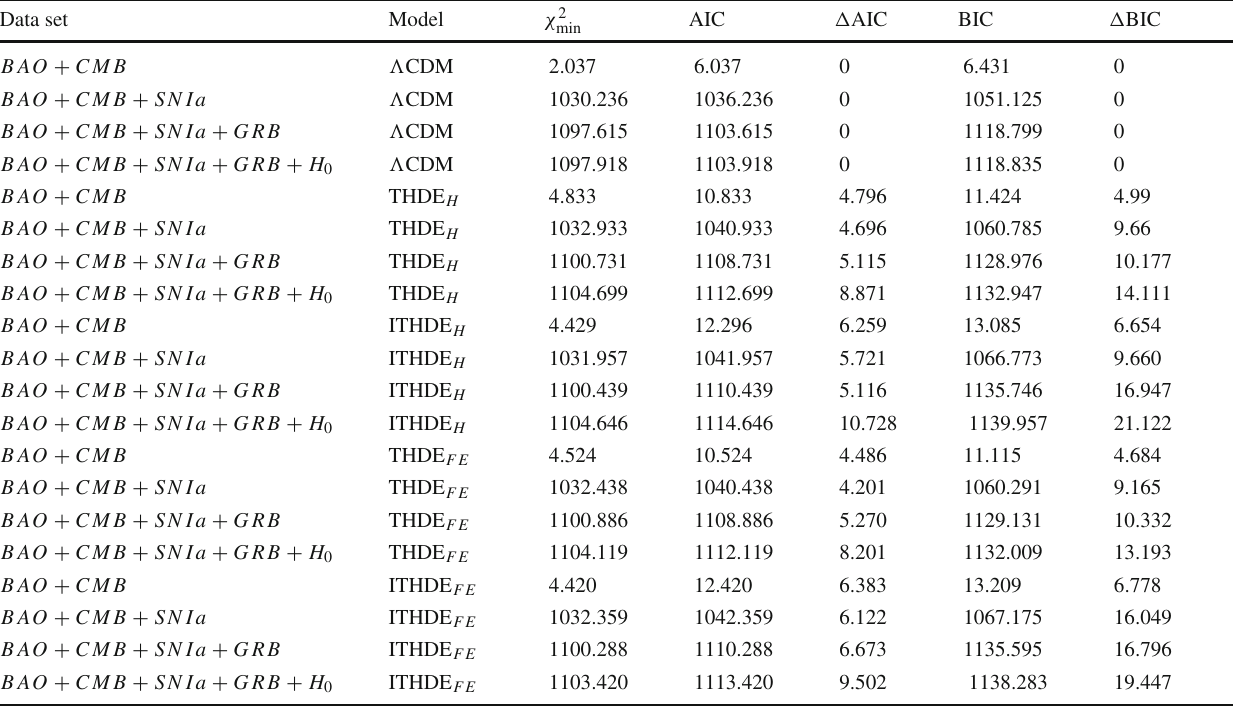
Table 4 Summary of the AIC and BIC values calculated for inter- with N = 5 interacting THDE, N = 4 for non-interacting THDE and N = 3 for the (cid:2) CDM models. Here we have 1169 data points. The H acting and non-interacting THDE model with respect to the reference (cid:2) CDM model. (cid:10) AIC = AIC − AIC (cid:2) (cid:10) BIC = BIC − and FE index stand for the Hubble horizon and the future event horizon i CDM and i BIC (cid:2) CDM in which i denotes the number of models { i = 1 , 2 ,..., N }